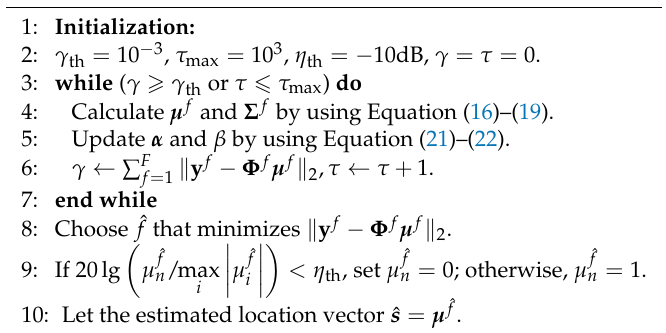
Algorithm 1 Location Vector